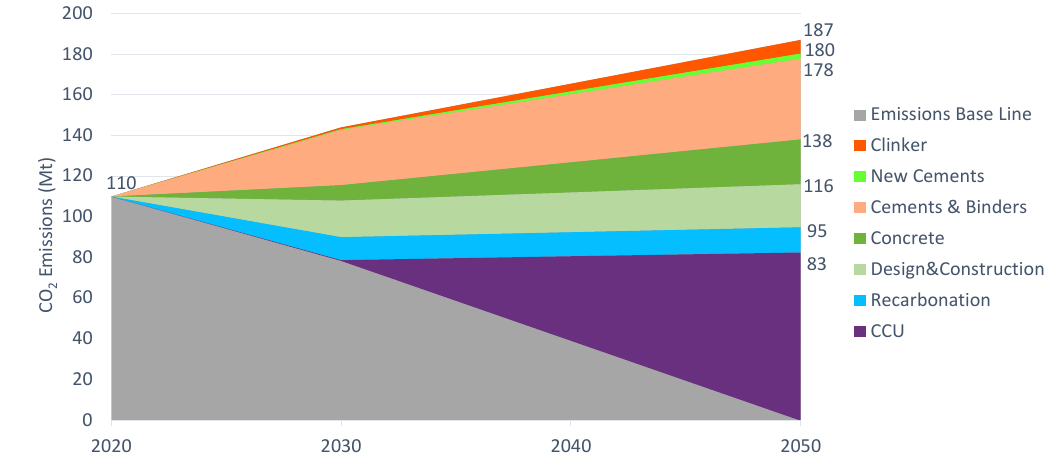
Figure 4. The road to net zero emissions by 2050 from concrete in LAC: contributions by levers (Source: